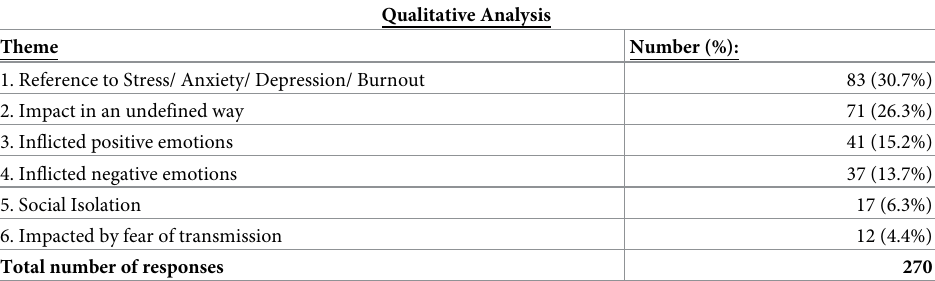
Table 3. Results obtained from the qualitative analysis of how the COVID-19 pandemic has impacted the sample